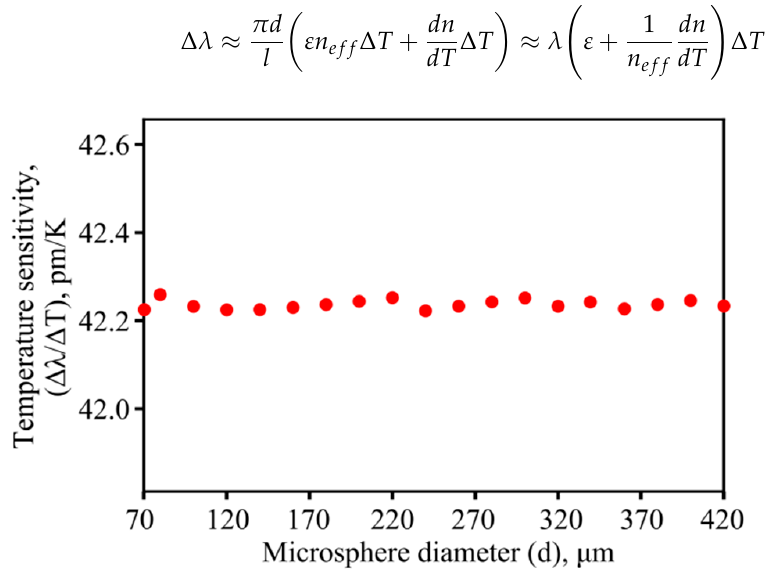
Figure 4. Numerically simulated steady-state sensitivity ∆ λ / ∆ T as a function of d . Therefore, ∆ λ / ∆ T is almost a constant value for modes near a given wavelength. Namely, when using As 2 S 3 chalcogenide microspheres having diameters from several tens to several hundreds of microns, the predicted sensitivity is ~42 pm/K. However, small (Figure 4). The explanation is that the eigenfrequencies and corresponding n eff found by solving Equation (4) are slightly varied for the fundamental WGMs (nearest to 1.55 µ m) in microspheres with different